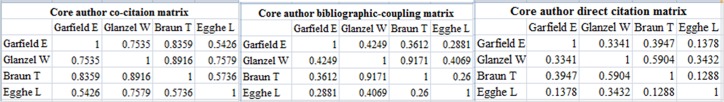
Normalized matrixes of tripartite citation analysis.